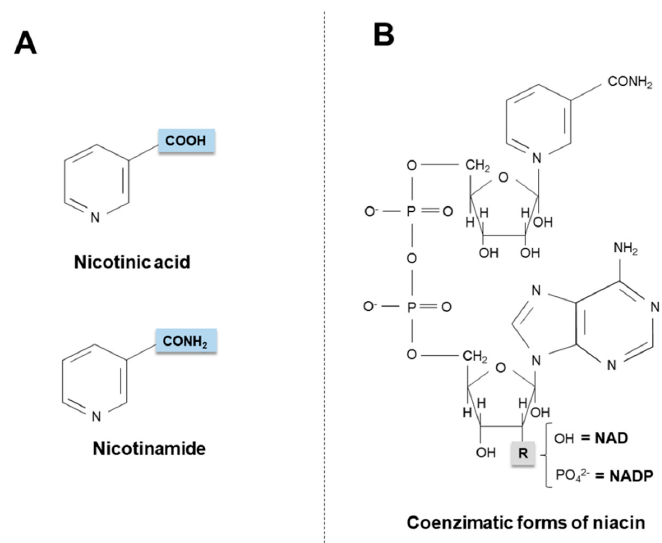
Figure 1. Chemical structures of niacin vitamers ( A ) and active coenzymatic forms ( B ). NAD: nicotinamide adenin dinucleotide. NADP: nicotinamide adenin dinucleotide phosphate.